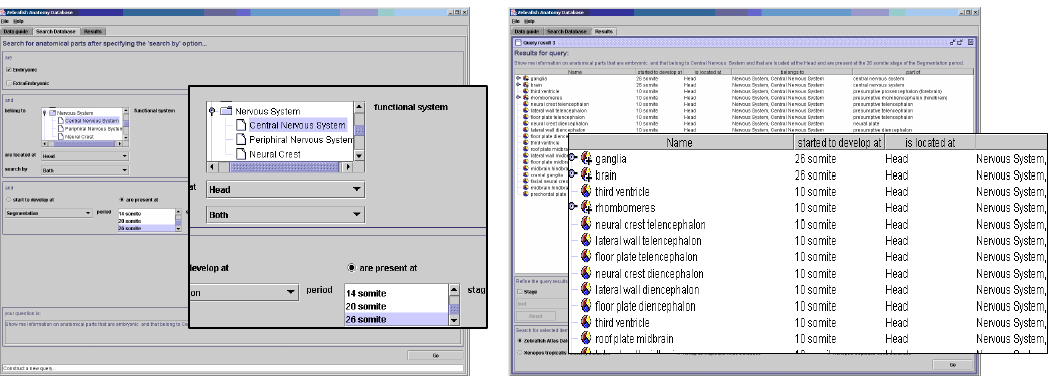
Figure 4: (Left) The applet to query the ontology database. Through this applet users are able to construct a query and submit it to the database to generate on the fly a search result. In this example we constructed the following query: ‘search for all anatomical tissues present at ‘26 somite’, belong to the central nervous system and located in head’. (Right) The result screen shows the query result with anatomical structures and their